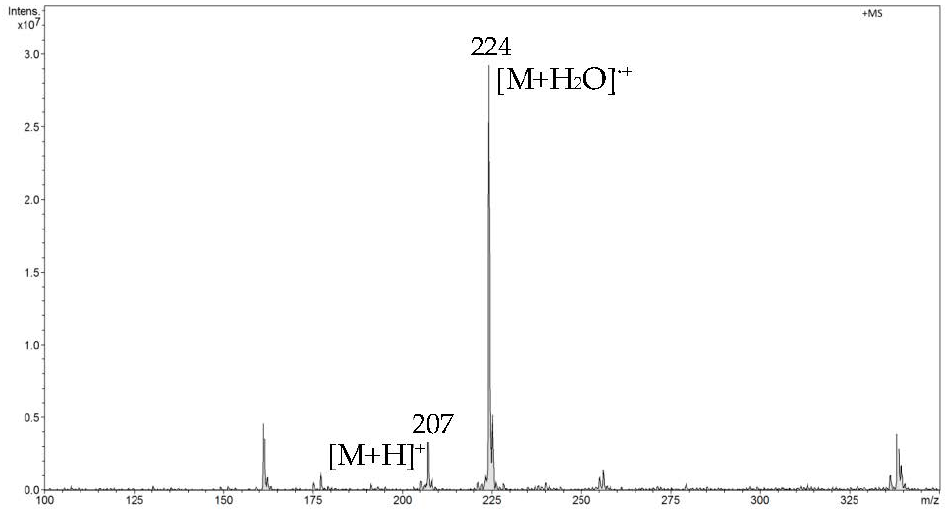
Figure 5. The FAPA-MS spectrum of Figure 5. The FAPA ‐ MS spectrum of ibuprofen.